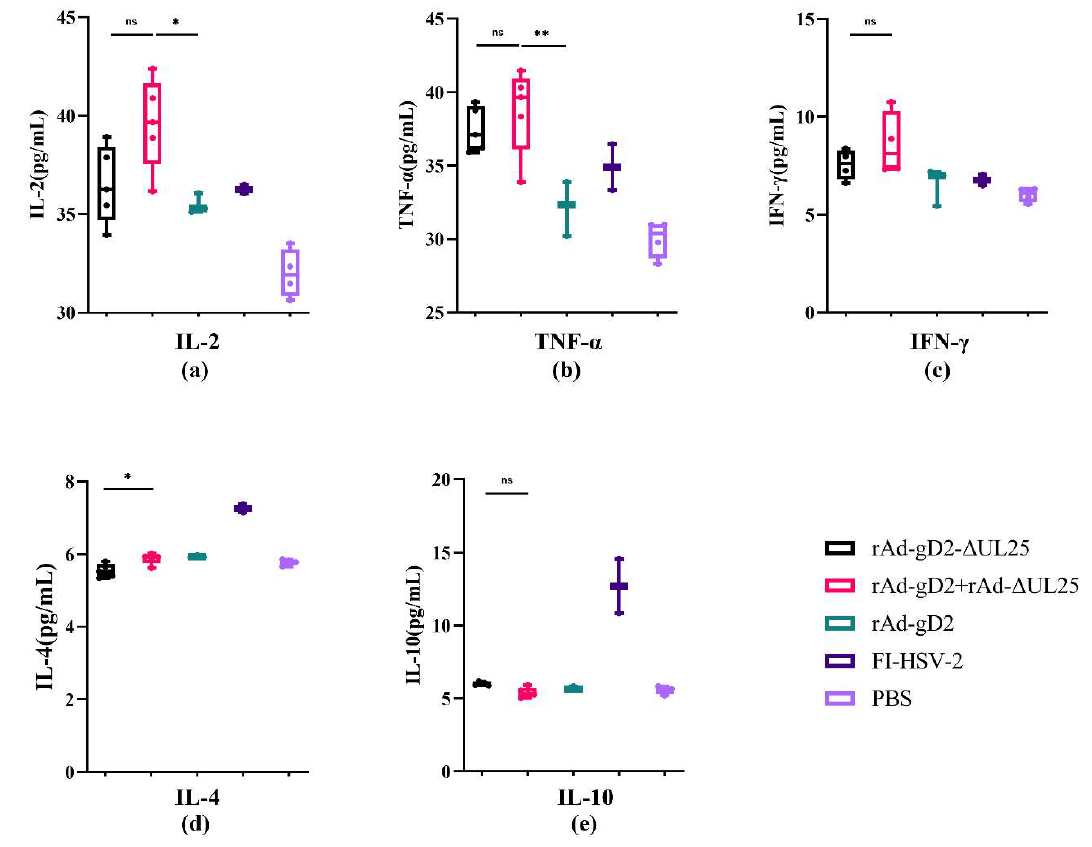
Figure 5. Cellular response to HSV-2-infected guinea pigs immunized with vaccines. Guinea pigs were evaluated for their Th1 (IL-2, TNF- α , and IFN- γ ) and Th2 (IL-4 and IL-10) cytokines levels in serum. The secretion of cytokines IL-2 ( a ), TNF- α ( b ), IFN- γ ( c ), IL-4 ( d ), and IL-10 ( e ) in serum was measured by ELISA. * p < 0.05; ** p < 0.01; ns, not statistically